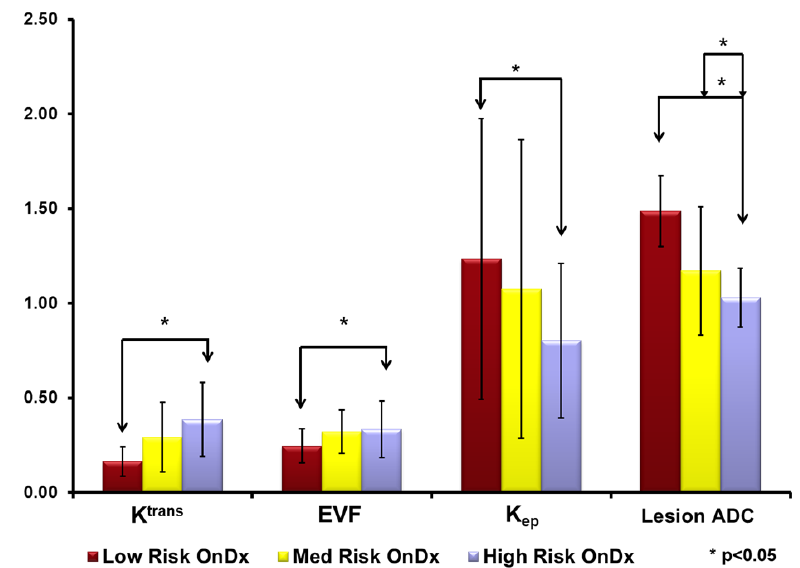
Figure 3. Bar graphs of quantitative multiparametric MRI parameters for each risk group from the OncotypeDX (OnDx). There are significant differences between each group of patients in the apparent diffusion coefficient (ADC (×10 −3 mm 2 /s)) of water and the Pharmacokinetic Dynamic Contrast Enhanced (PK-DCE) metrics. The PK-DCE metrics are the volume transfer constant ( K trans (min −1 )) and the fractional volume of the extracellular extravascular space (EVF (V e )). * p < 0.05.